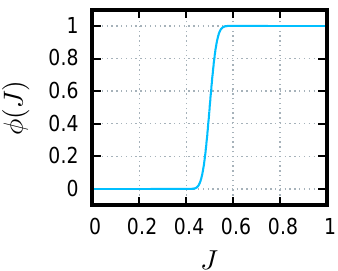
Figure 2. Cutoff function φ . Its value is used as a reliability factor in the numerical